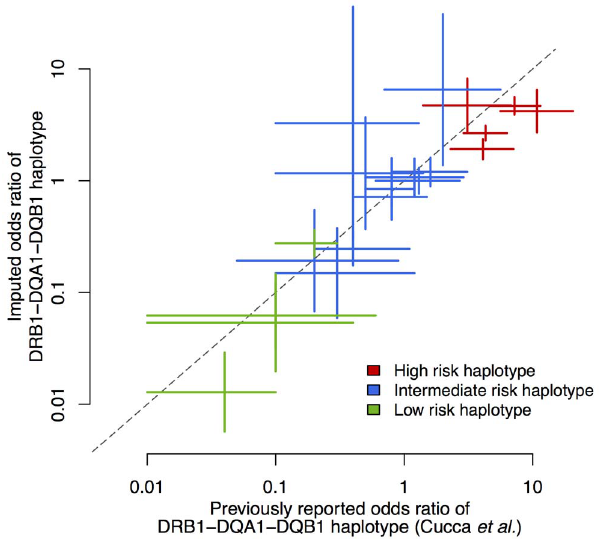
Figure 5. Haplotype risk analysis of WTCCC type 1 diabetes data. We assessed the risk of haplotypes spanning HLA-DRB1 , HLA- DQA1 and HLA-DQB1 , and compared these to the published risk estimates from an independent study [20]. The published odds ratios were based on transmission/non-transmission of alleles from familial data, while our odds ratios were estimated from case/control data. We used the same classification scheme by dividing haplotypes into three risk groups. The odds ratios are computed with respect to the